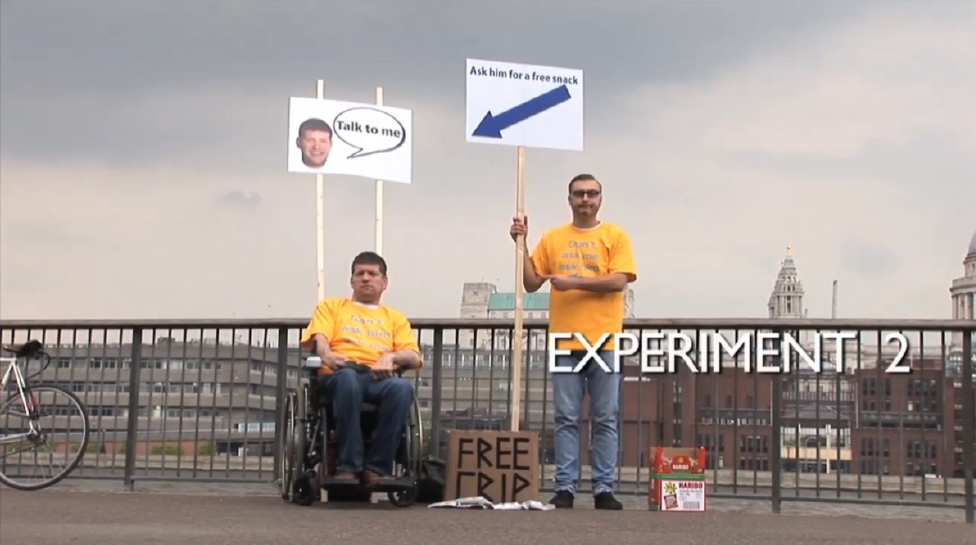
Figure 3. Laurence Clark offering free snacks on the street to those who to talk to him instead of Hans. Reproduced under the permission of fair dealing; copyright Clark 2014.